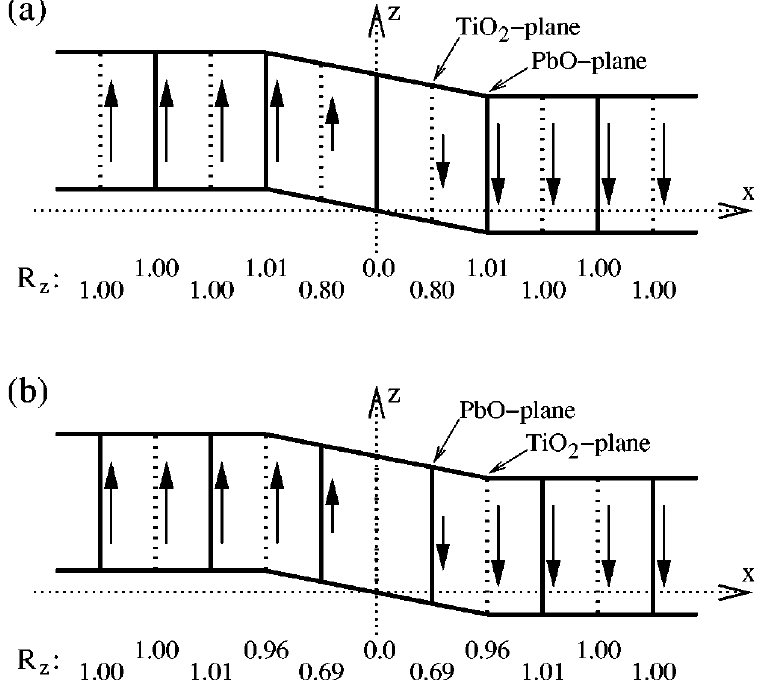
Figure 18. Change of polarization across the ( a ) Pb-centered and ( b ) Ti-centered 180° domain wall. R z denotes the ferroelectric distortion of each lattice plane in the z direction, in units of the distortion associated with the bulk spontaneous polarization. (Reprinted with permission from [173]; Copyright 2002 by the American Physical